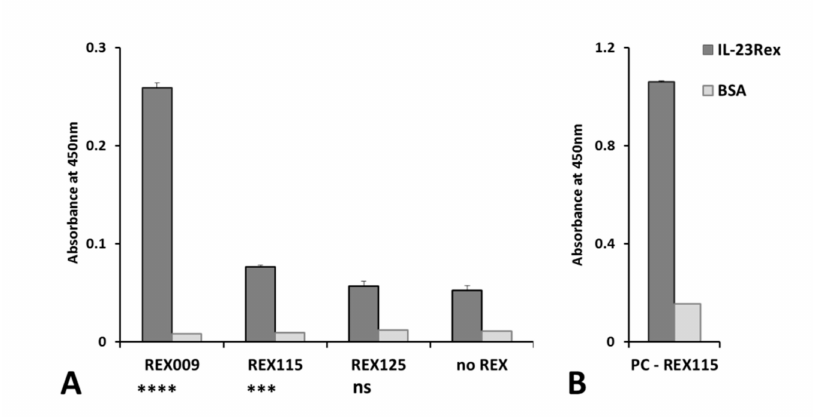
Figure 6. Binding of secreted REX variants in ELISA. The 96-well plate was coated with recombinant IL-23Rex protein, and samples of the medium with secreted REX proteins were applied ( A ). Purified protein REX115–TolA diluted in PBSTB was used as a positive control ( B ). The binding of REX proteins to IL-23Rex, and to BSA as a negative control, was detected by anti-DDDDK tag antibody [M2] conjugated with horseradish peroxidase (HRP) (A), or by streptavidin with HRP (B). Each bar represents the mean value with standard deviation and significant di ff erences between mean values of the negative control (no REX), and the samples were analyzed by ANOVA (*** p < 0.004, **** p < 0.001, ns: no significant di ff